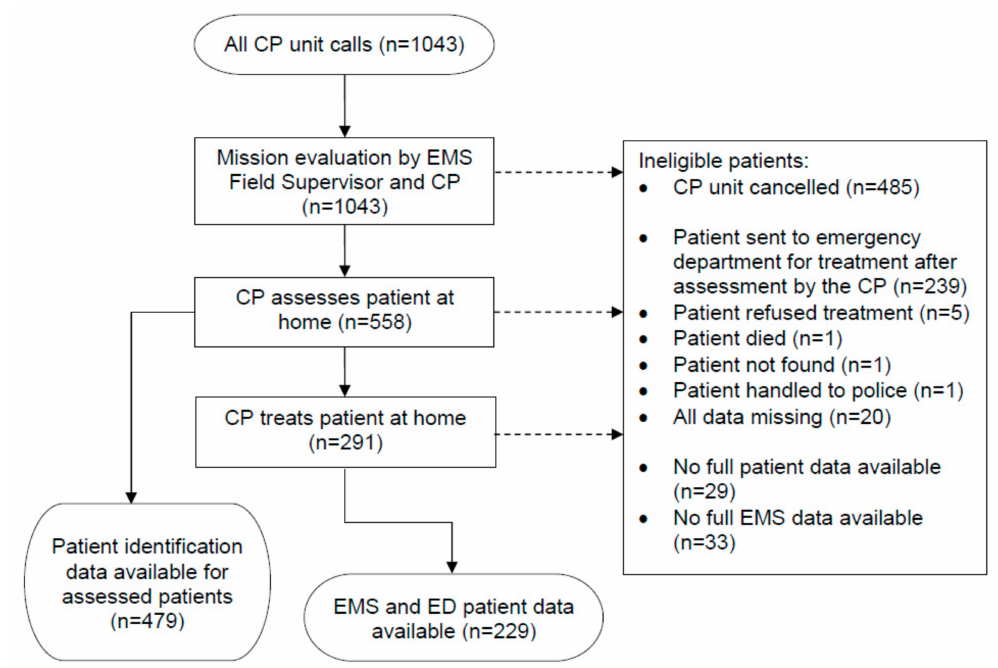
Figure 2. Data collection process. ED: emergency